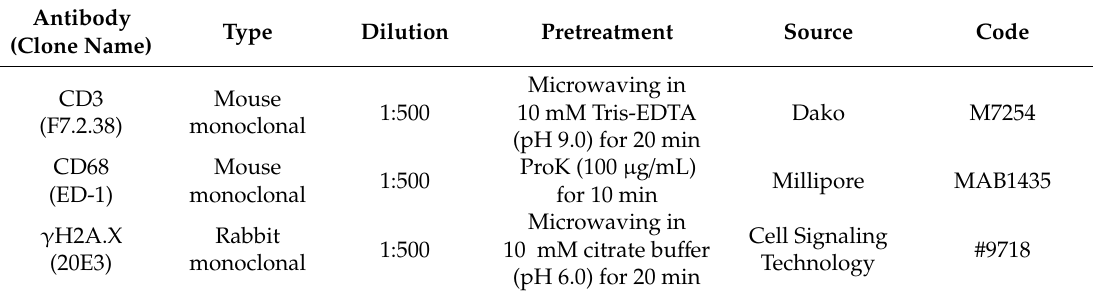
Table 1. The list of antibodies used for immunohistochemistry.